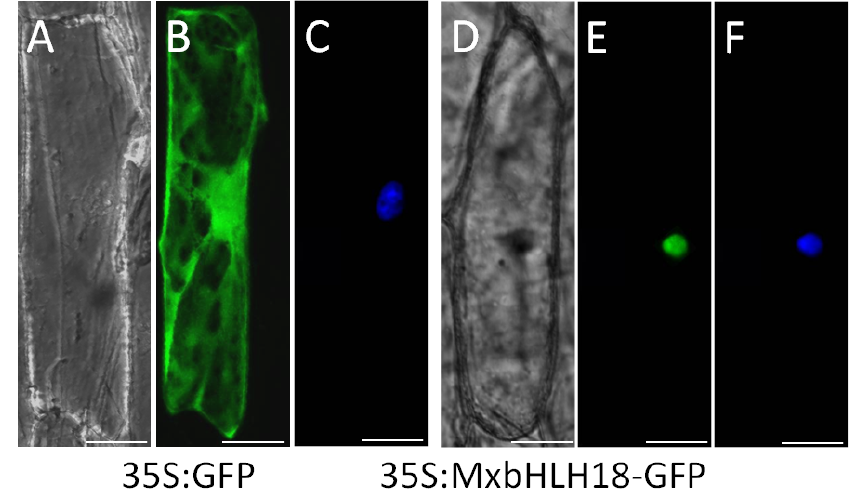
Figure 2. MxbHLH18 protein was localized in the nucleus. The 35S:GFP (control) and 35S:MxbHLH18-GFP fusion protein were expressed in onion epidermal cells. The expression results were observed under fluorescent microscope under strong light ( A , D ), dark field ( B , E ) and DAPI staining images ( C , F ). Scale represents 5 μ M.